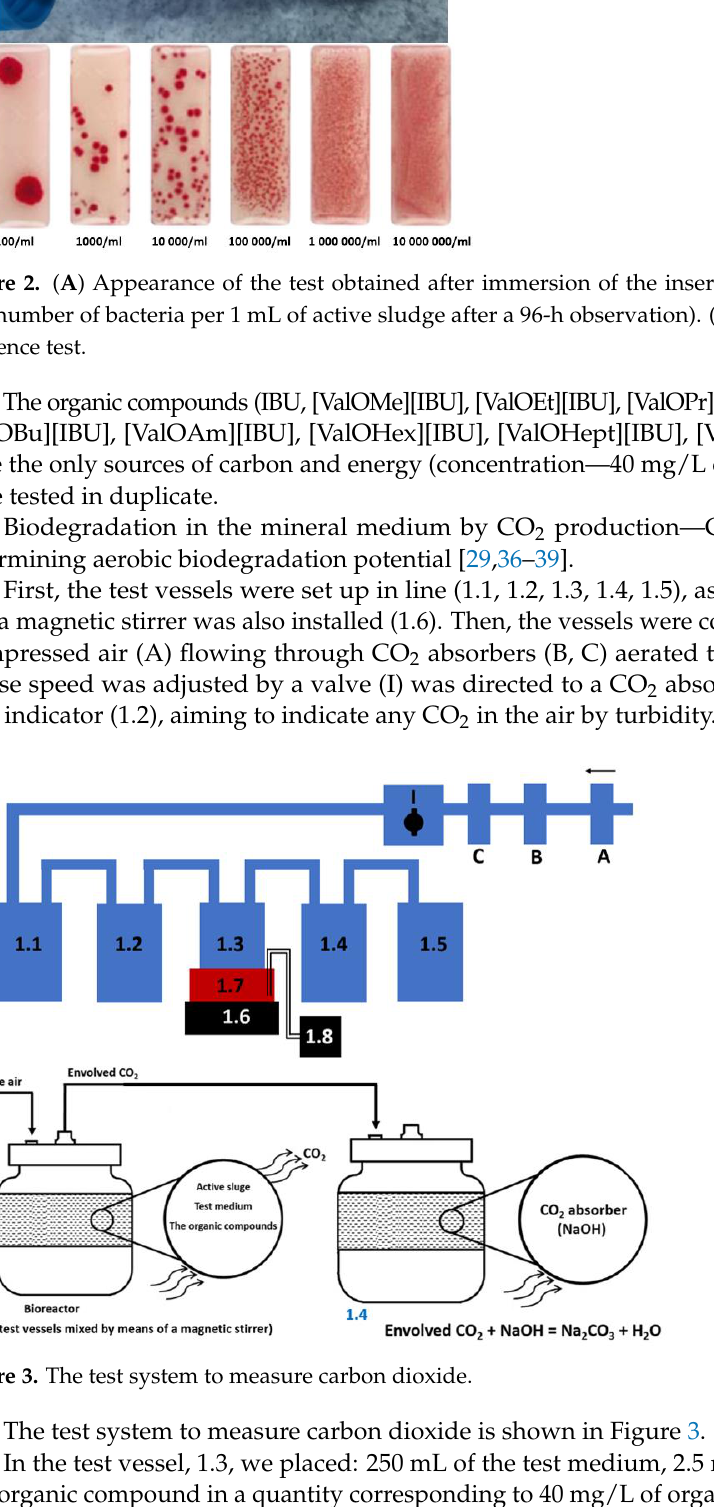
Figure 3. The test system to measure carbon dioxide. The test system to measure carbon dioxide is shown in Figure